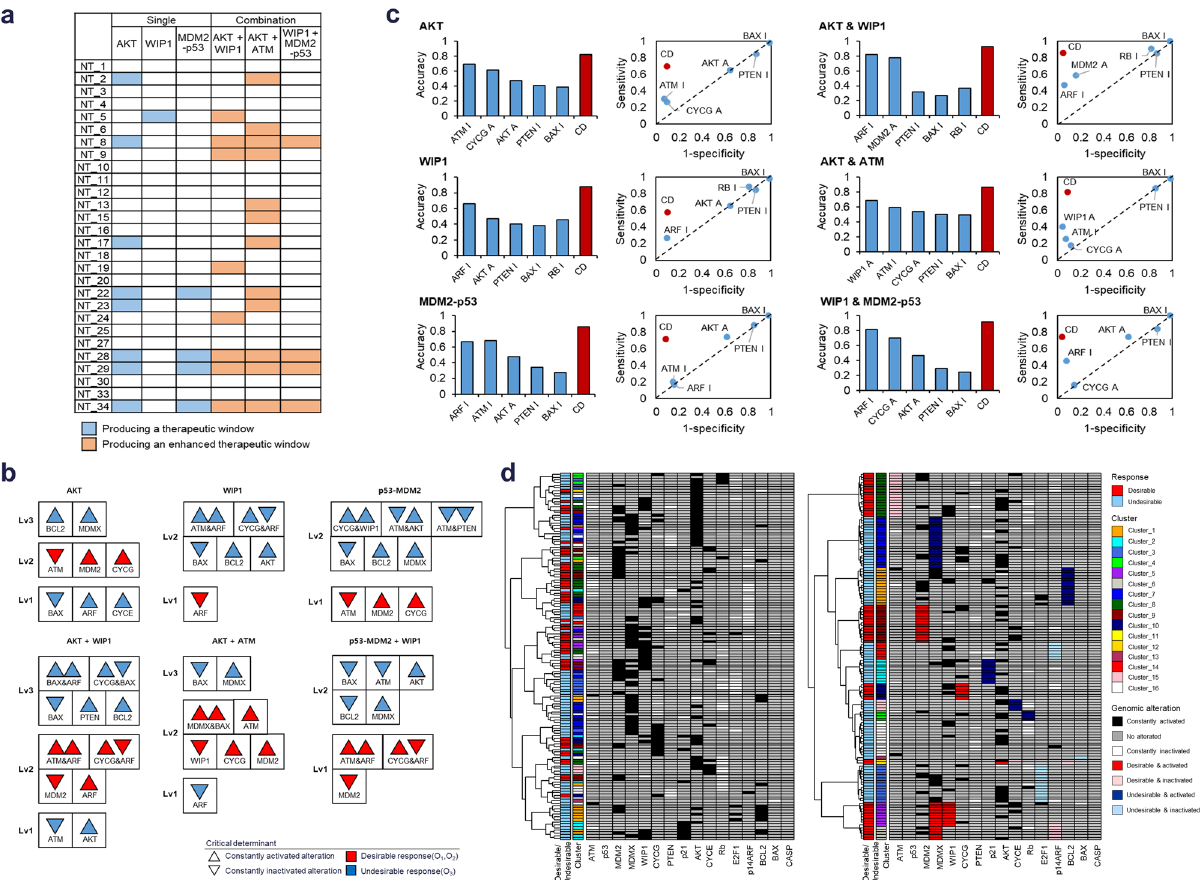
Fig. 5 Prediction of drug response and strati fi cation of patients based on critical determinants. a The selected 3 single and 3 combination perturbations from the cell line-speci fi c networks. b Critical determinants and their dominance relationship obtained from the cell line-speci fi c networks. Upward pointing triangle indicates an activating genetic alteration; downward pointing indicates inactivating genetic alteration. Red indicates D response; blue indicates U response. Critical determinants at higher levels (Lv) are dominant over those at lower levels in determining the drug response. c Prediction of drug responses in the patient-speci fi c networks using statistically identi fi ed markers or the dominance relationship between critical determinants (CD). d Strati fi cation of patient-speci fi c networks to the response of AKT inhibition based on unbiased genetic alterations (left) or on the dominance relationship between critical determinants obtained from patient-speci fi c networks (right). The fi rst column shows D or U responses of patient-speci fi c networks. The second column shows group for each critical determinant. The remaining columns show genetic alterations in patient-speci fi c networks (black: constantly activated alteration, white: constantly inactivated alteration, gray: no alteration). Among the genomic alterations, critical determinants for each patient are highlighted in colors (light blue: constantly inactivated alteration as an U response marker, dark blue: constantly activated alteration as U response marker, red: constantly activated alteration as D response marker, pink: constantly inactivated alteration as D response marker). The cluster 1 – 15 are notated by the critical determinants in Supplementary Fig. 5 while the cluster 16 has no critical